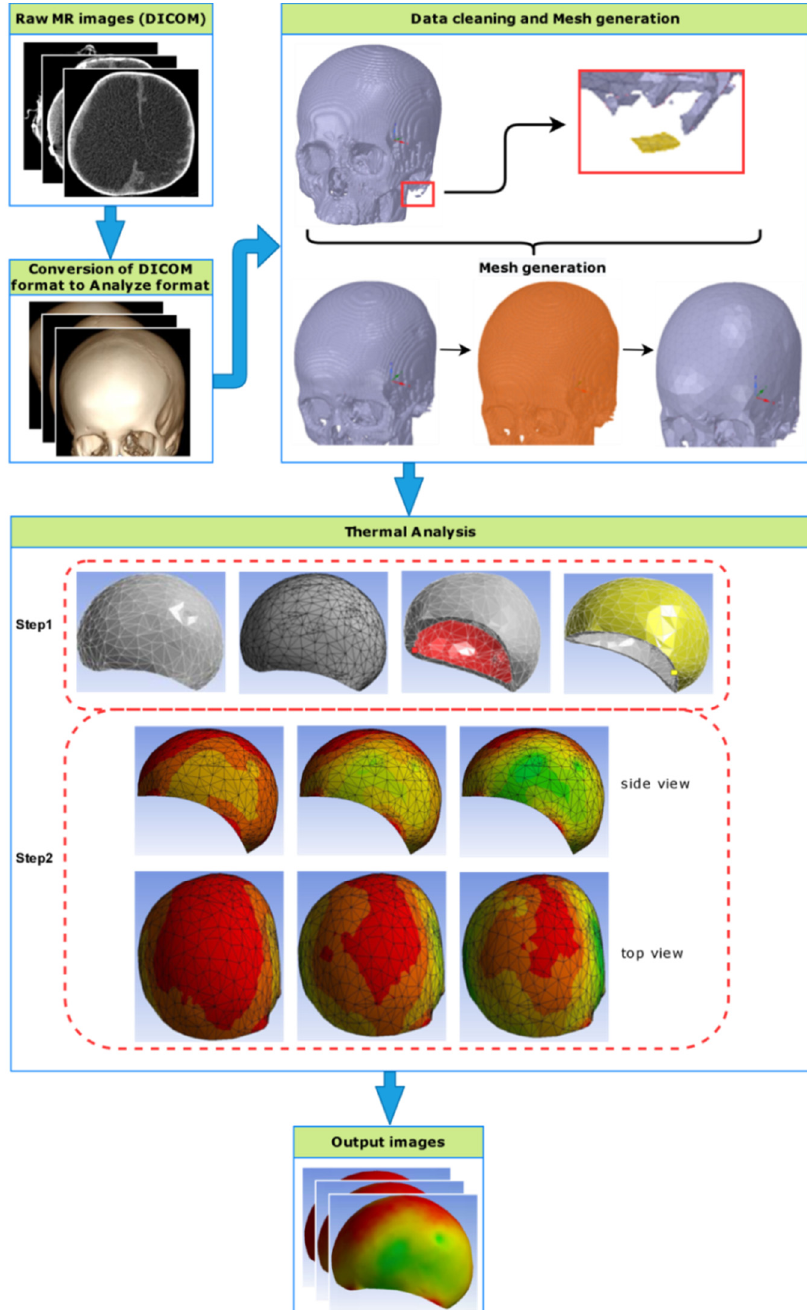
Figure 10. Graphical abstract of the proposed method.